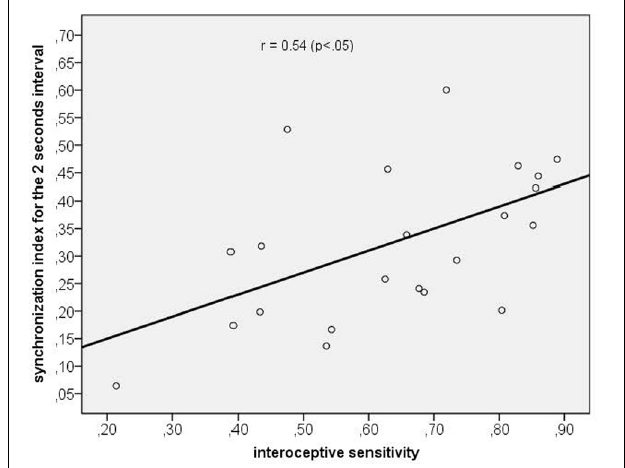
FIGURE 6 | Scatterplot between interoceptive sensitivity and the maximum synchronization index for the 2s time interval.